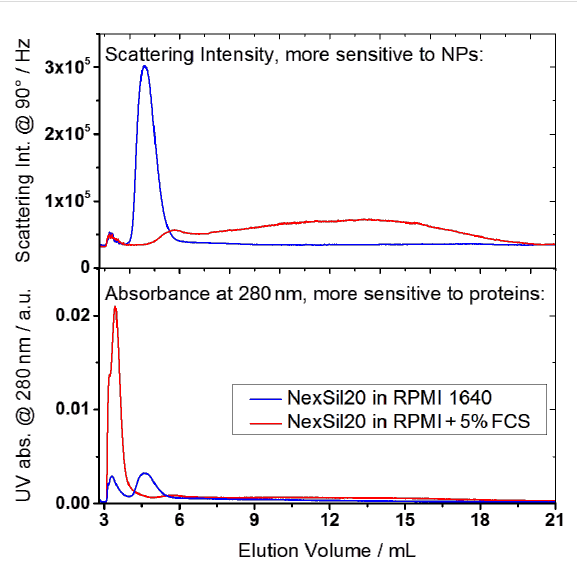
Figure 4: AF-FFF fractograms for NexSil20. Blue: NexSil20 prepared in RPMI cell medium; Red: NexSil20 prepared in RPMI cell medium in presence of 5 vol % FCS. The AF-FFF channel (ConSenxus) was operated with a cross flow of 2.5 mL/min and a detector flow of 1 mL/min, with a polysulfone membrane and a spacer of 190 μ m thick- ness, and with an eluate concentration of 200 mg/mL NaN 3 in deion- ized